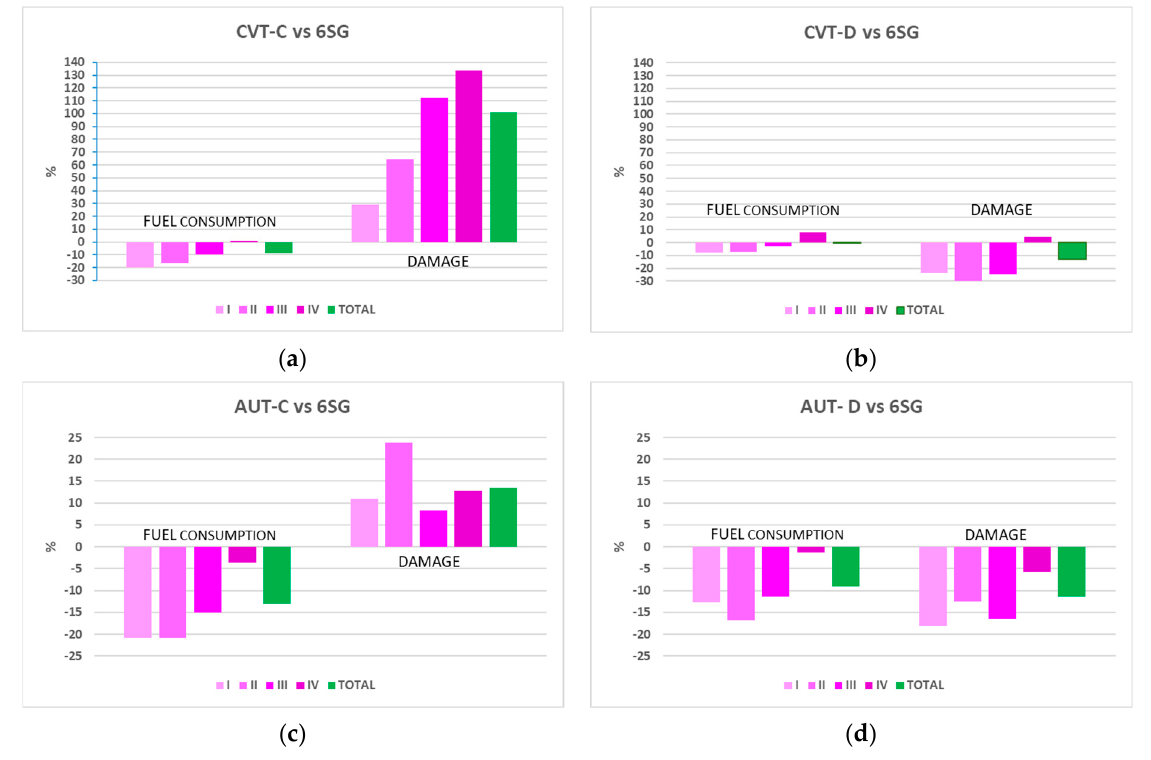
Figure 9. Percentage change in fuel economy and kilometer damage of the CVT ( a , b ) and AUT ( c , d ) powertrains compared to the 6GS powertrain. Red columns refer to the four phases of the WLTC cycle, and the green column refers to the total path of the cycle.